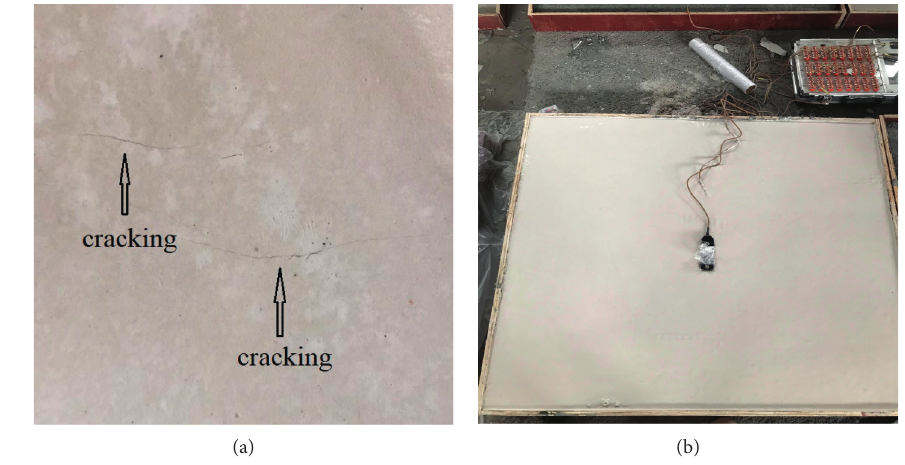
Figure 11: Difference of panels. (a) T0. (b) T2.